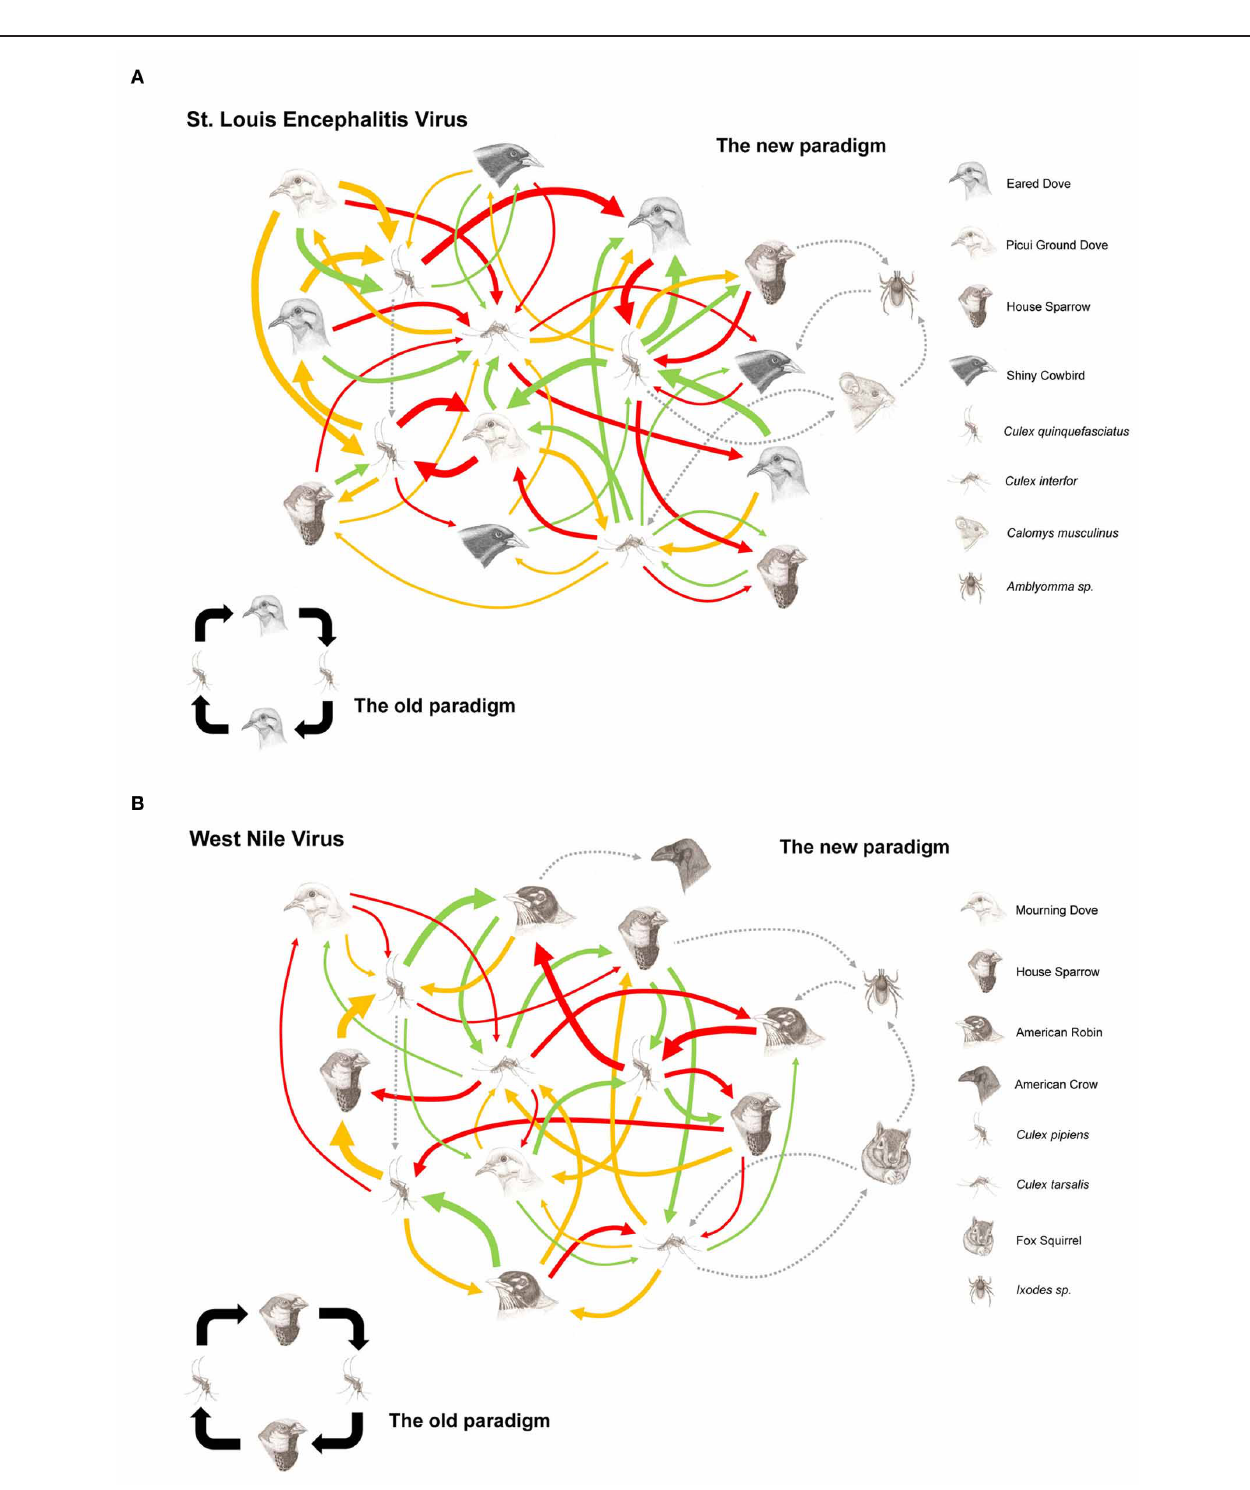
determined by the vector host preference, vector-host population density, vector and host competence). The spotted line arrows represent alternative transmission way (venereal and/or transovarial transmission), hosts (mammals) and vectors (ticks). The colored arrows represent the season in which the vector-host relation takes place (green: Spring, red: Summer, orange: